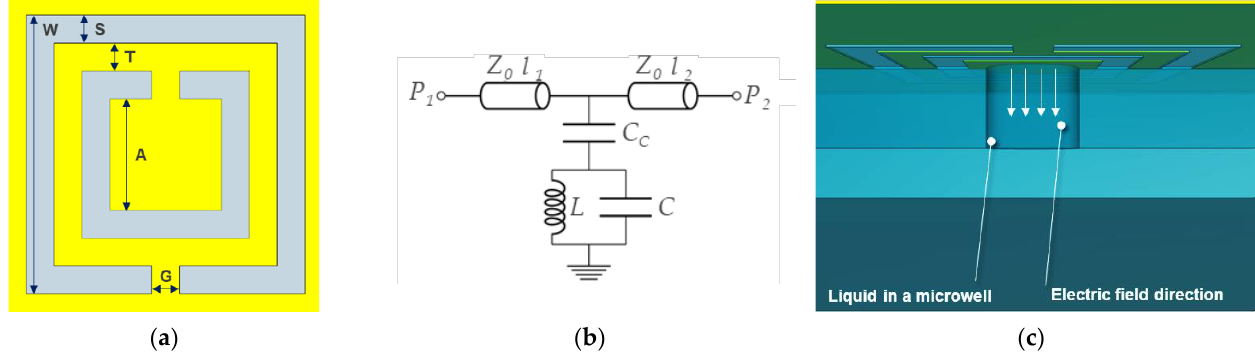
Figure 2. ( a ) A schematic of the CSRR in yellow with width W and A , spacing S , trace width T , and gap G . ( b ) The equivalent circuit of the CSRR. ( c ) The electric field direction of the CSRR with respect to the central patch and the microwell.